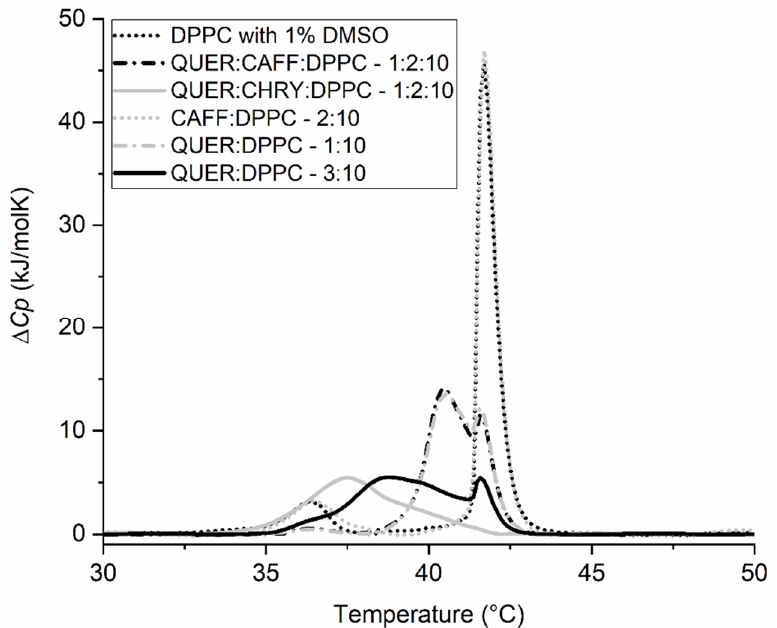
Figure 8. DSC thermograms of 1,2-dipalmitoyl- sn -glycero-3-phosphatidylcholine (DPPC) liposomes in 20 mM HEPES (pH = 7.0) buffer and 1% dimethyl sulfoxide (DMSO) (negative control), and the addition of caffeic acid (CAFF), quercetin (QUER), or the mixtures of QUER with either CAFF or chrysin (CHRY) (all in 1% DMSO and HEPES) at different n compound(s) : n DPPC molar ratios. Δ C p is the change in heat capacity. Table 3. The thermodynamic profile of the 1,2-dipalmitoyl- sn -glycero-3-phosphocholine lipids (MLV) at pH 7.0, at different molar ratios ( n:n ) of chrysin, quercetin, caffeic acid, and their binary mixtures.